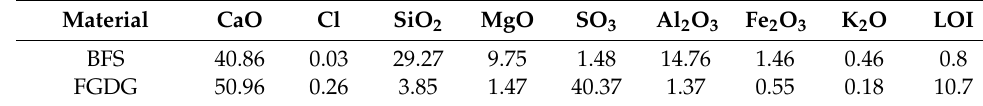
Figure 1. Laser particle size analysis of ( a ) BFS and ( b ) FGDG. Table 3. XRF results of BFS and FGDG (%).